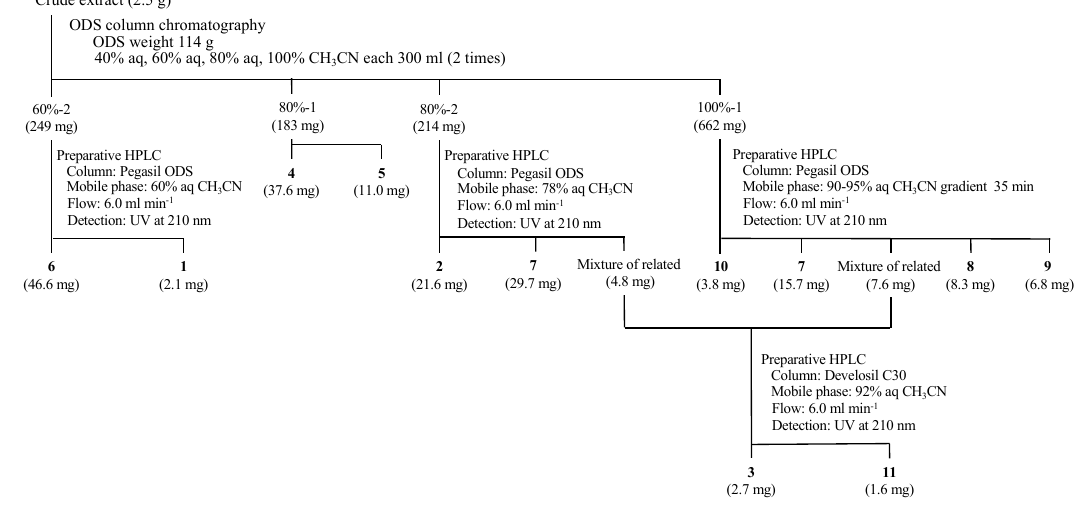
Figure 2. Isolation procedure of terpendoles.